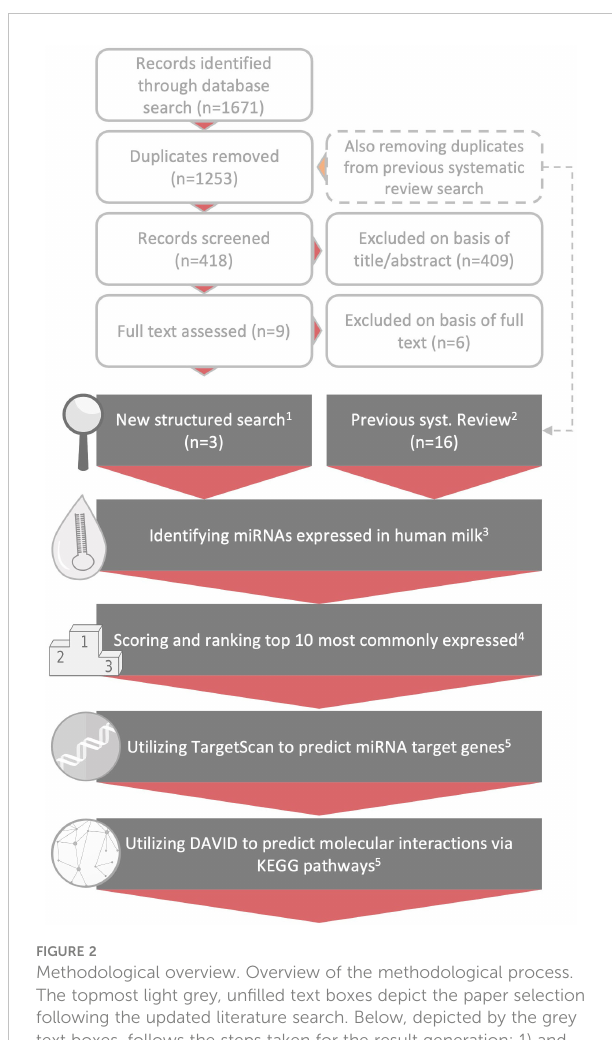
FIGURE 2 Methodological overview. Overview of the methodological process. The topmost light grey, un fi lled text boxes depict the paper selection following the updated literature search. Below, depicted by the grey text boxes, follows the steps taken for the result generation: 1) and 2) illustrates how the three papers included after the new search was combined with the 16 papers analyzing miRNA in breast milk from our previous ncRNA review (14), 3) on basis of these 19 papers we identi fi ed the highest expressed breast milk miRNAs in each study (Supplementary B, Table S1), 4) thereafter the miRNAs were scored according to paragraph 2.2 (also refer to Supplementary B, Tables S2-S5) and for the last two steps denoted 5) please refer to method paragraph 2.2 and Supplementary B, Tables